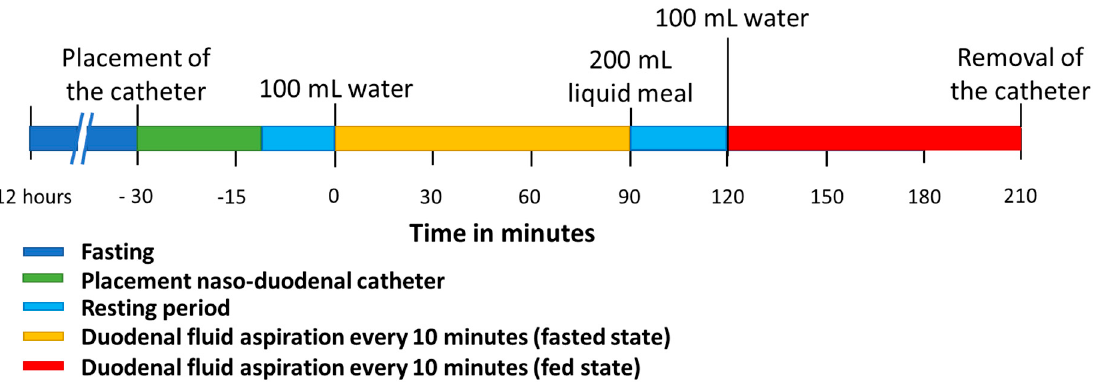
Figure 1. Timeline of the clinical study protocol to aspirate duodenal fluids in fasted and fed state.